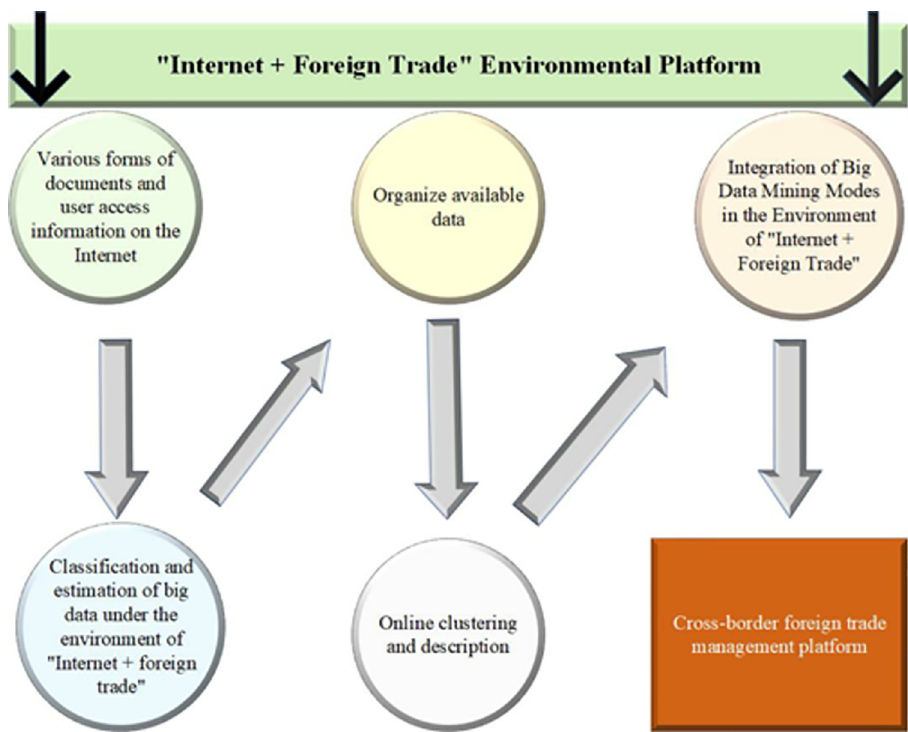
Fig 4. Mining process module of controllable relevance big data mining model of foreign trade goods sales under the background of "Internet plus foreign trade".